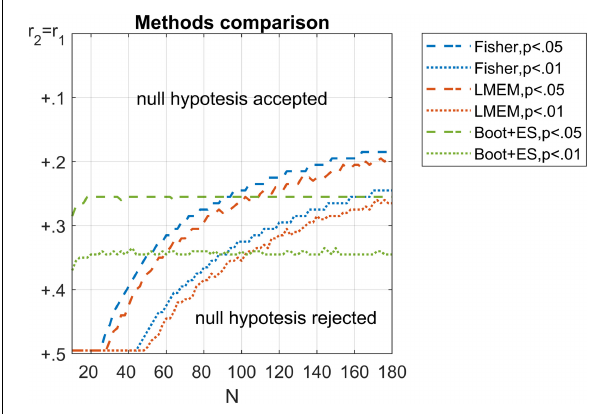
FIGURE 2 | Comparison among Fisher (in blue), LMEM (in red), and bootstrap (in green) p -values. Thresholds of p = 0.05 (dashed lines) and p = 0.01 (dotted lines) are represented for each method. Only the lower half of the values are reported here for visual